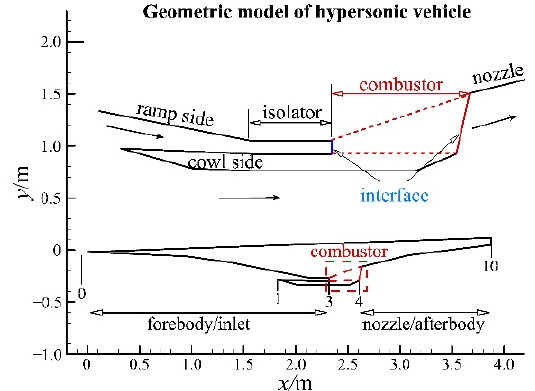
Figure 1. Schematic diagram of a hypersonic vehicle.